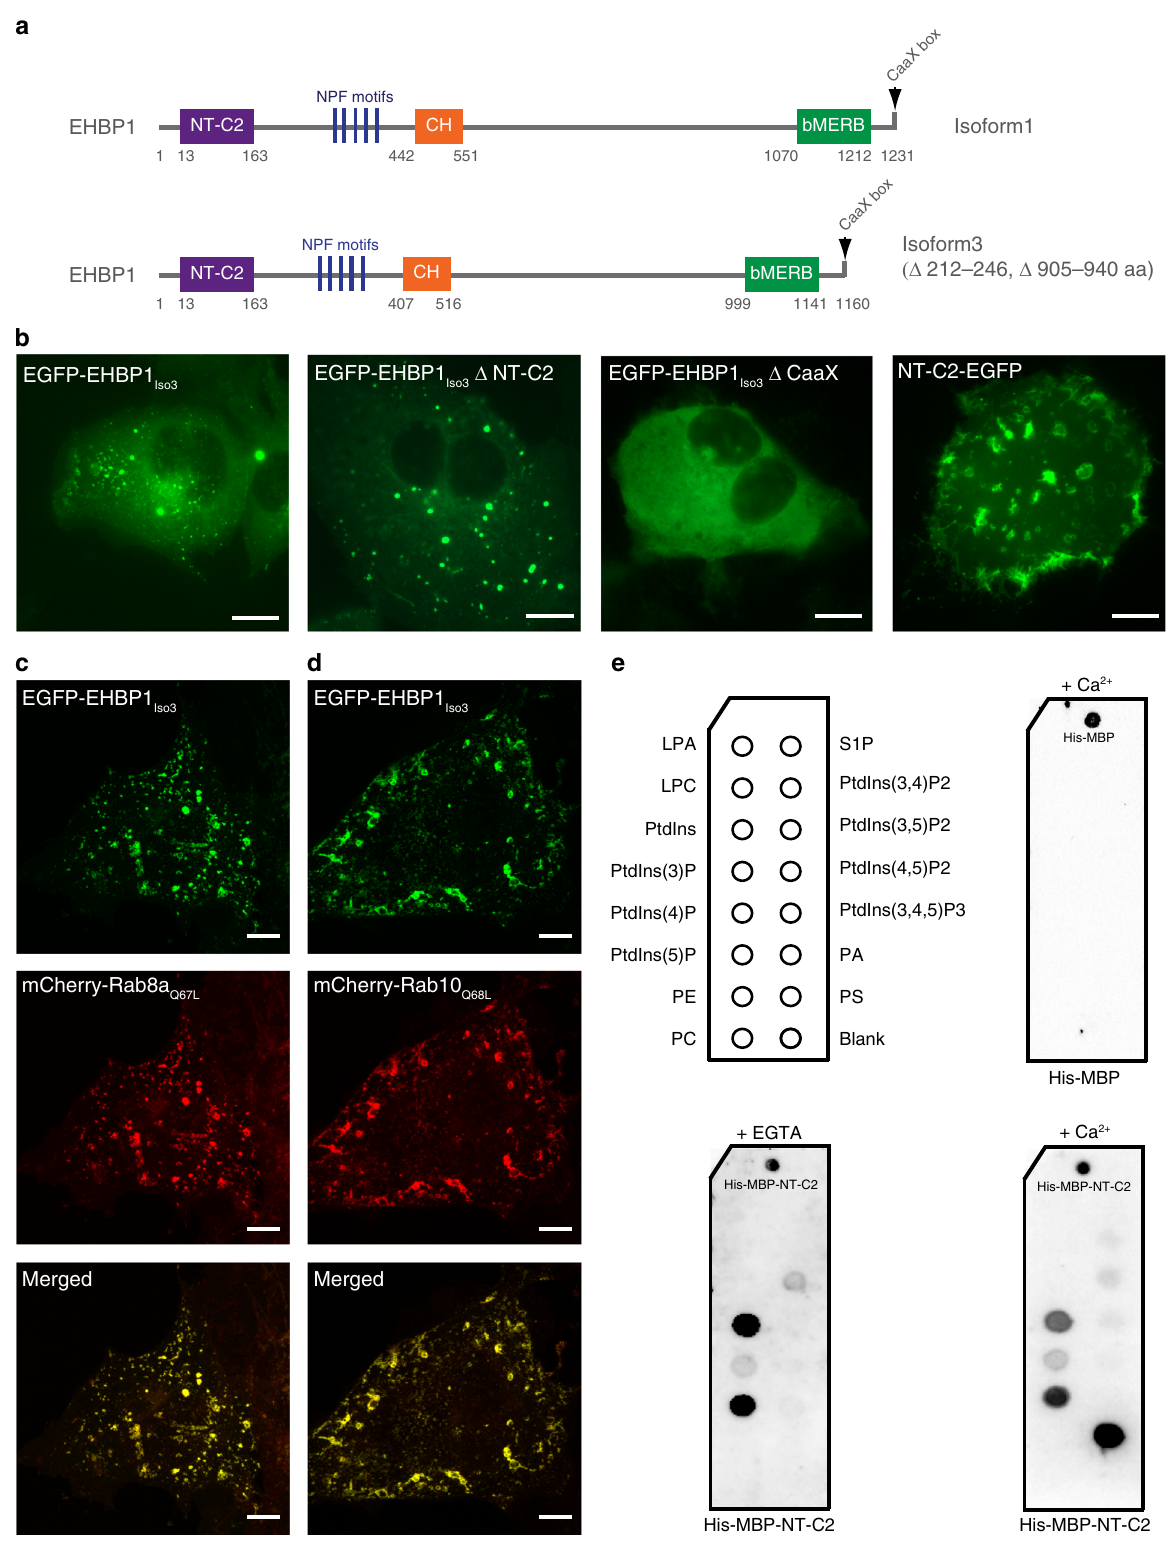
LRRK2, a serine/threonine kinase phosphorylates threonine of switch II of Rab8a T72 /10 T73 . Phosphorylated Rabs are GDI resistant, thus increasing their lifetime on the membrane 17,18